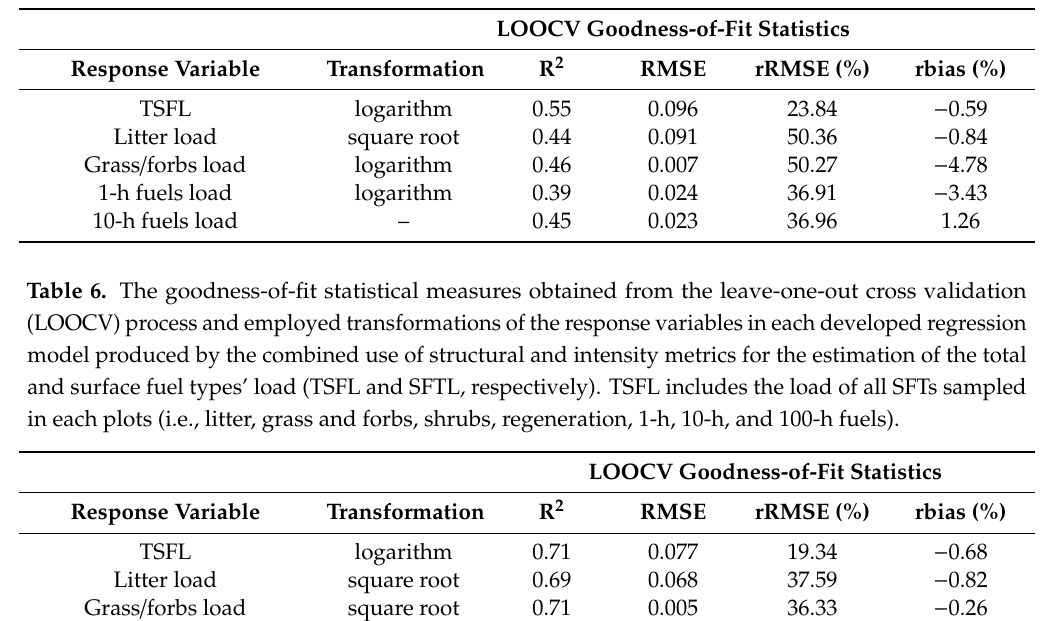
Table 5. The goodness-of-fit statistical measures obtained from the leave-one-out cross validation (LOOCV) process and employed transformations of the response variables in each developed regression model including the LiDAR intensity distribution metrics for the estimation of the total and surface fuel types’ load (TSFL and SFTL, respectively). TSFL includes the load of all SFTs sampled in each plot